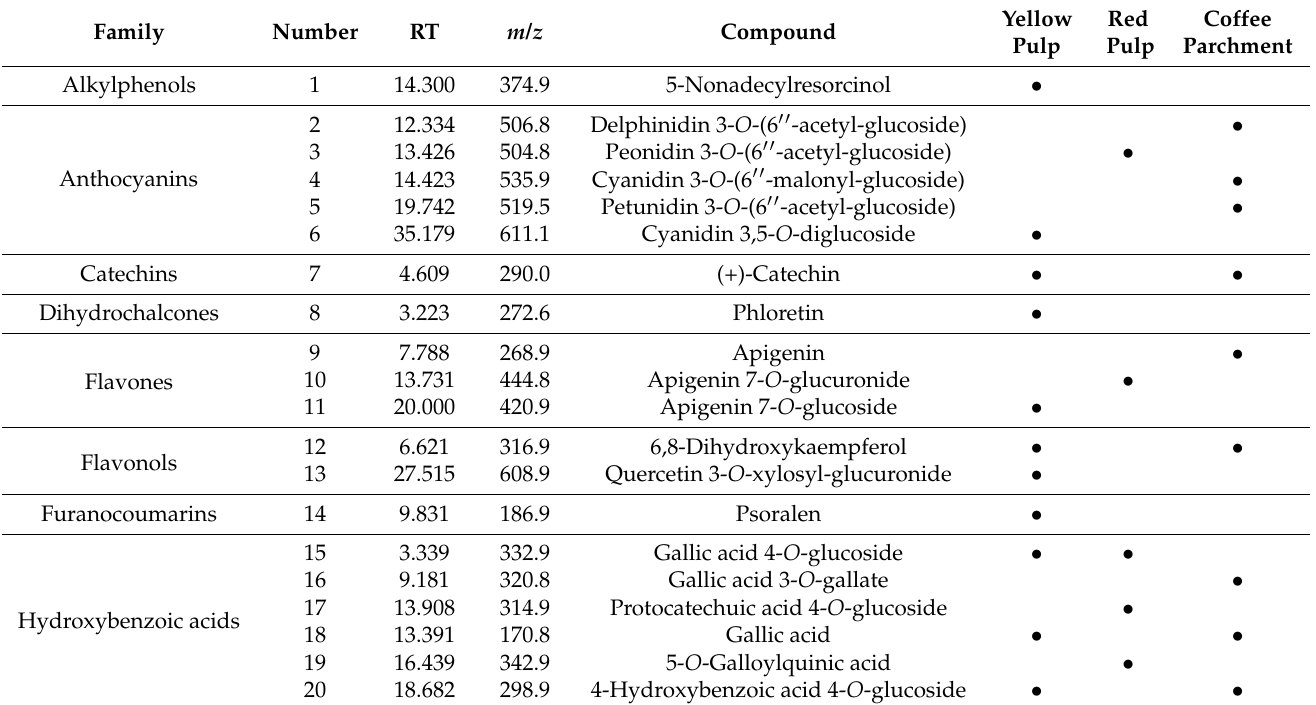
Table 1. HPLC-MS identified phenolic compounds on coffee agro-waste extracts, through their correlation using mass-to-charge ratio ( m / z ) and retention times. Their presence on the studied residues is indicated with a •